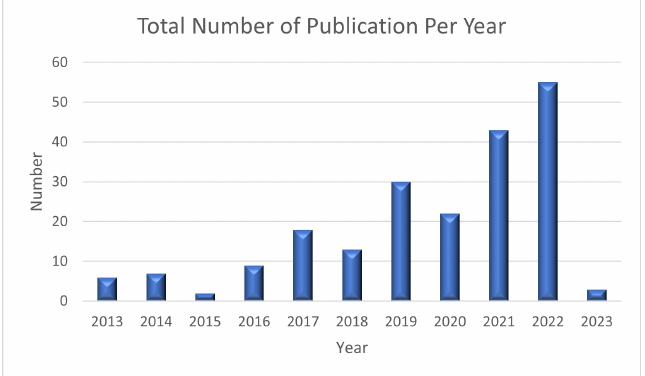
Figure 5. Reviewed paper distribution by year of